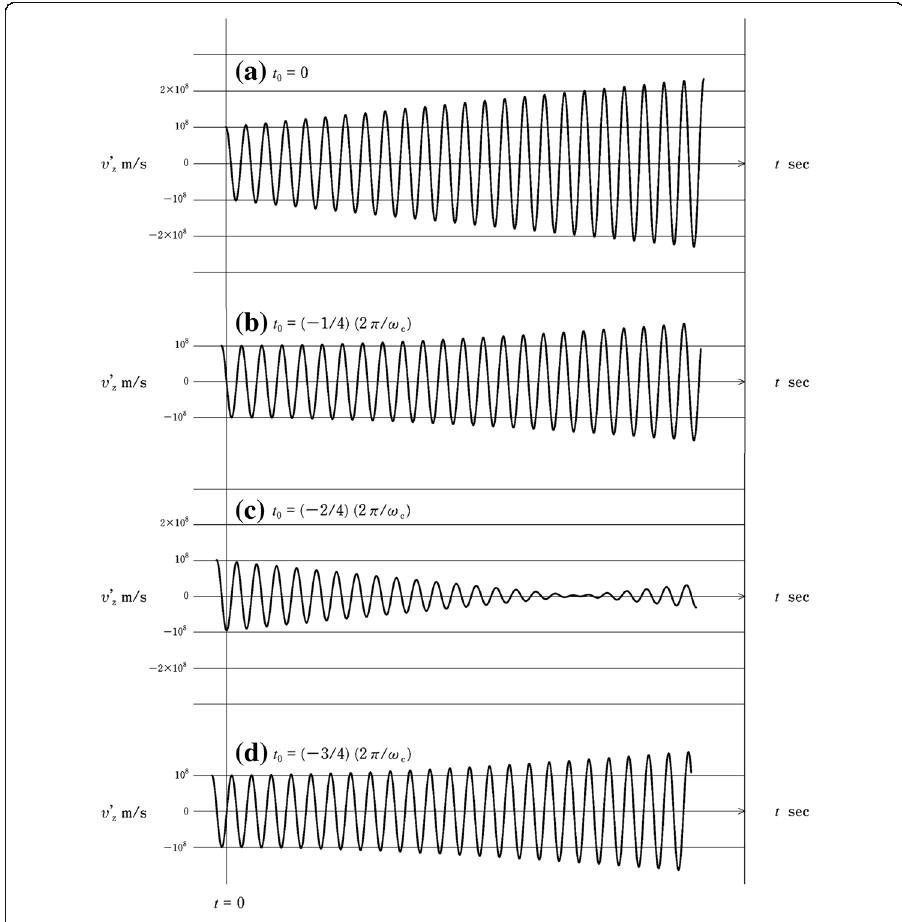
Fig. 2 a-d Dependence of a velocity υ ′ z ( z - component) of a nonrelativistic electron on the phase of an electric field. The conditions are the same with in Fig. 1a-d, except for the following two changes: c } ¼ ð 3 (cid:2) 10 8 m = sec Þ 2 → ð 3 (cid:2) 10 8 (cid:2) 10 6 m = sec Þ 2 t ¼ t = c } . So, we obtain nonrelativistic characteristics by setting c " to (3×10 8 ×10 6 m/sec) 2 , from by the factor z 2 0